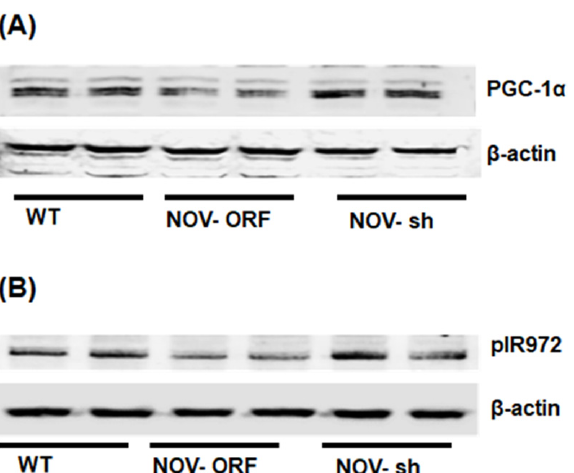
Figure 2. Mitochondrial function, inflammation, and insulin signaling in adipocytes with the over- expression of NOV (ORF NOV) or NOV knockdown (shNOV) in mice on an HFD. Western blot analysis of PGC-1 α ( A ), phosphorylated insulin receptor (pIR972) ( B ). Results are the average of two experiments run in duplicates.